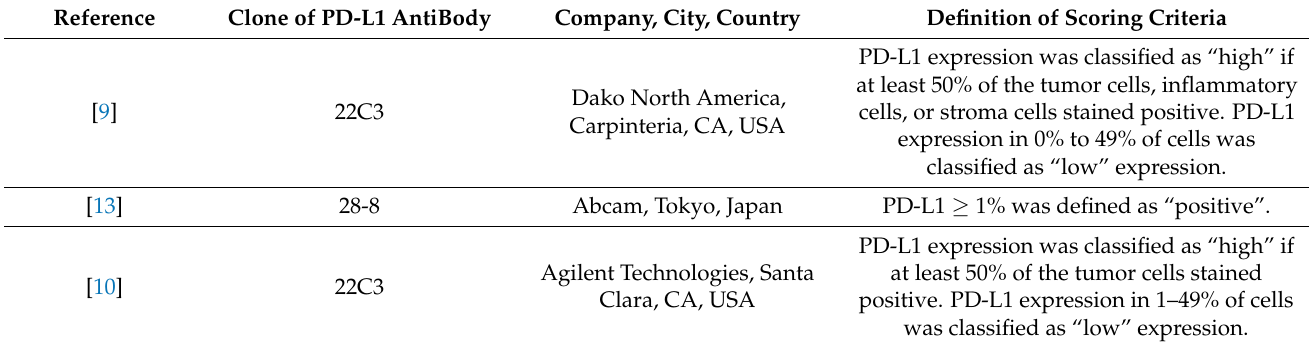
Table 4. Reagents and scoring criteria used for the assessment of